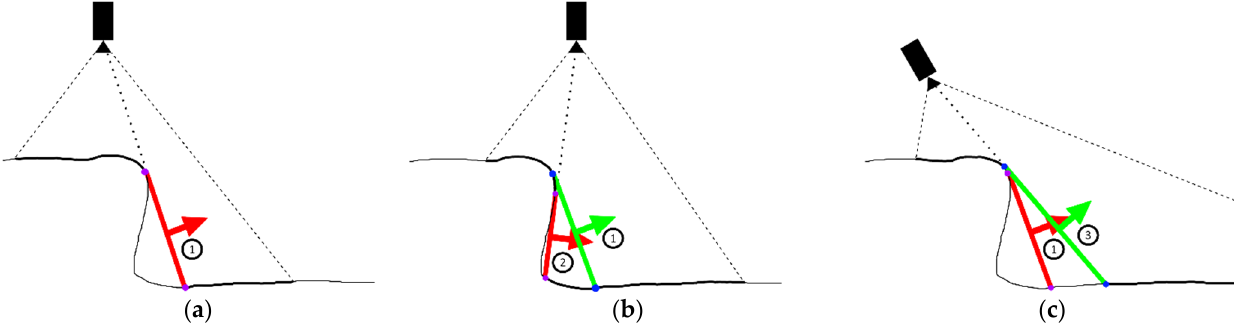
Figure 11. An examples of creation and deletion of DPlanes due to overlap, red colored DPlanes remain active while green DPlanes are invalidated: ( a ) Example 1; ( b ) Example 2; ( c ) Example 3.